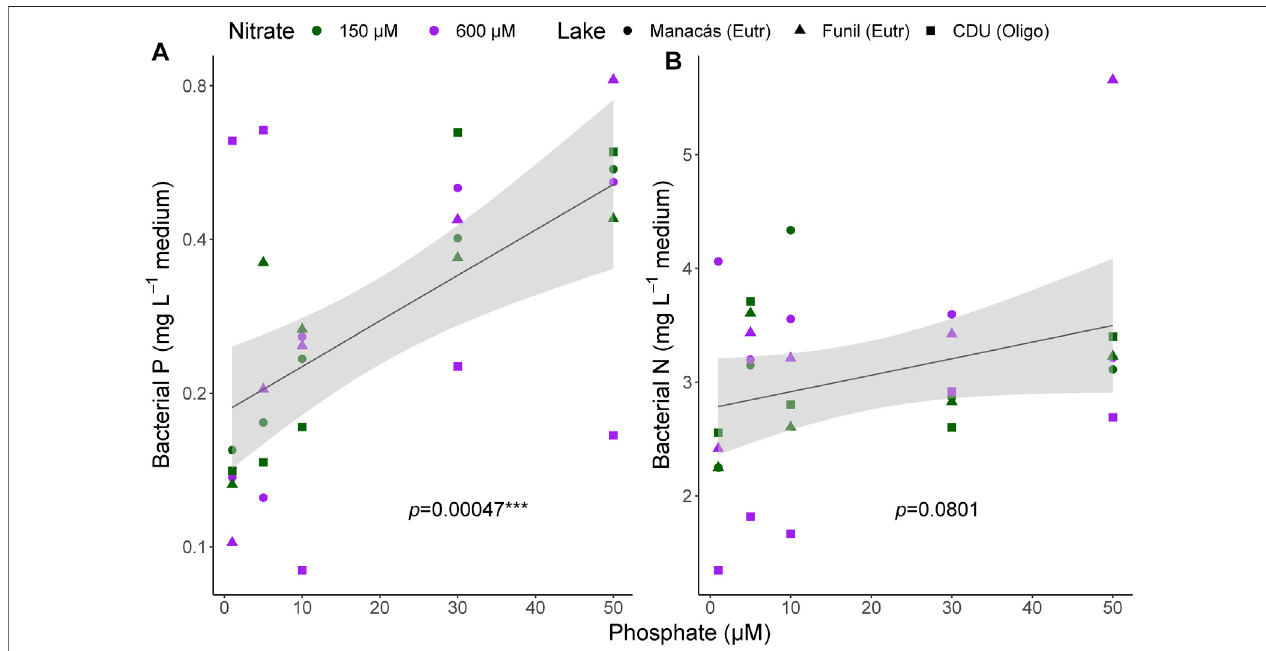
FIGURE 4 | Bacterial P (log-transformed, (A) and bacterial N (B) content per litre of medium at the end of the microcosm incubations. Fitted line according to linear regression, shading represents 95% con fi dence interval. Individual measurements are shown, colours represent [NO 3 − ] treatments, shapes represent lake oforigin, n = 30.